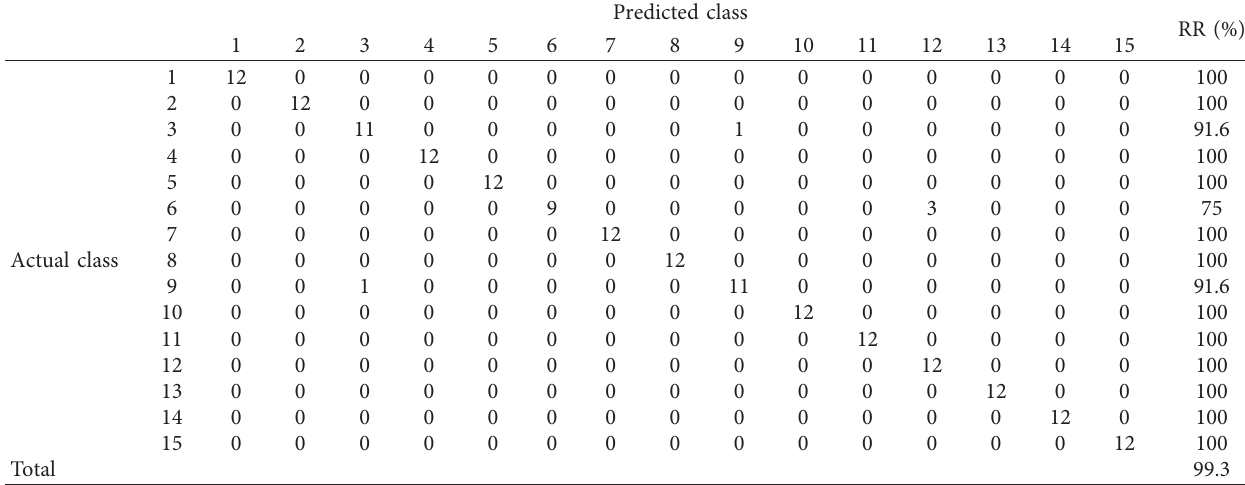
Table 4: Training sample SVM classification result.